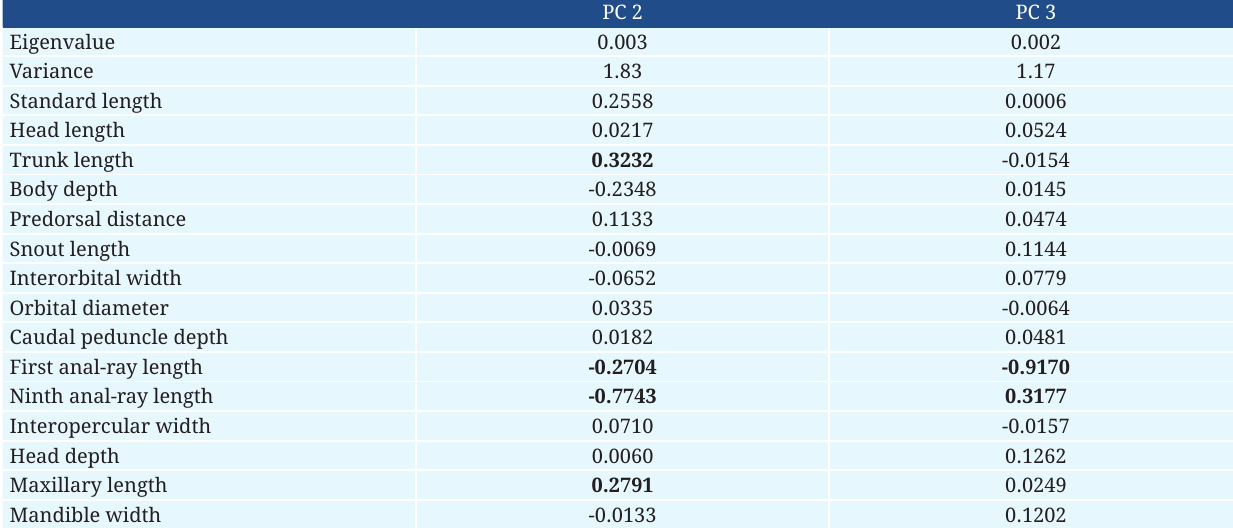
TABLE 2 | Loadings of variance and eigenvalues of morphometric measurements of Schizodon vittatus and S. trivittatus used in the Principal Component Analysis (PCA). Discriminant characters in